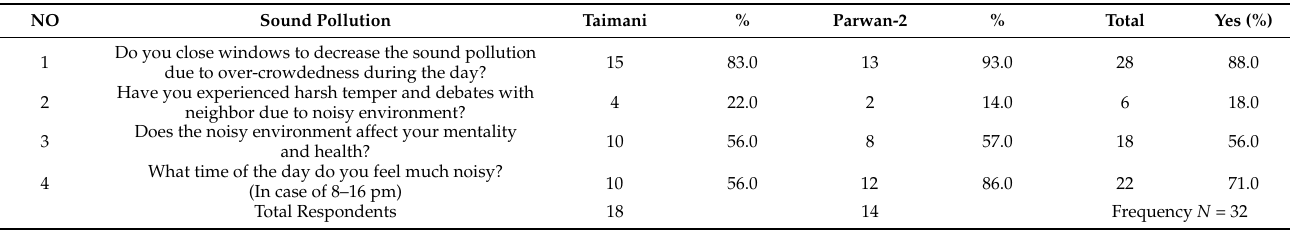
Table 6. Resident Response to Sound Pollution.